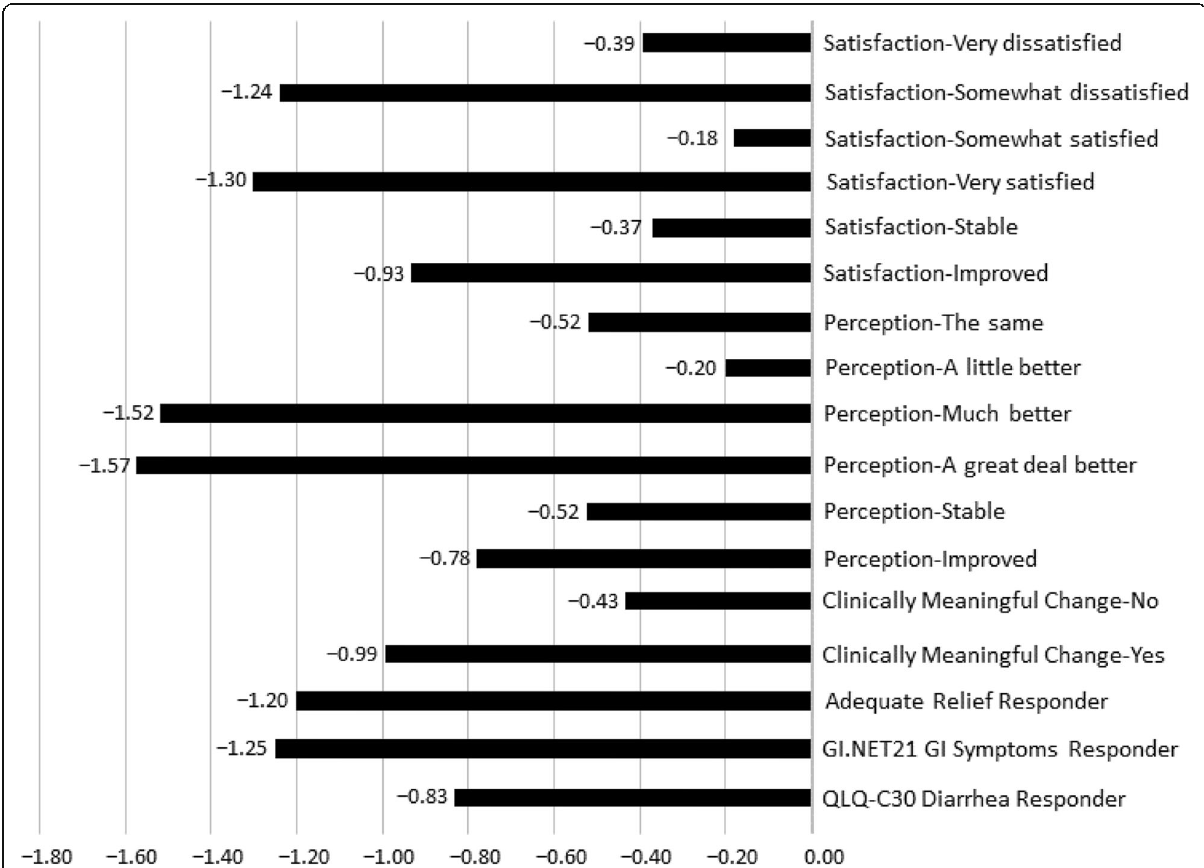
Fig. 1 Effect Sizes of Change in Overall BM Frequency from Baseline (ISP